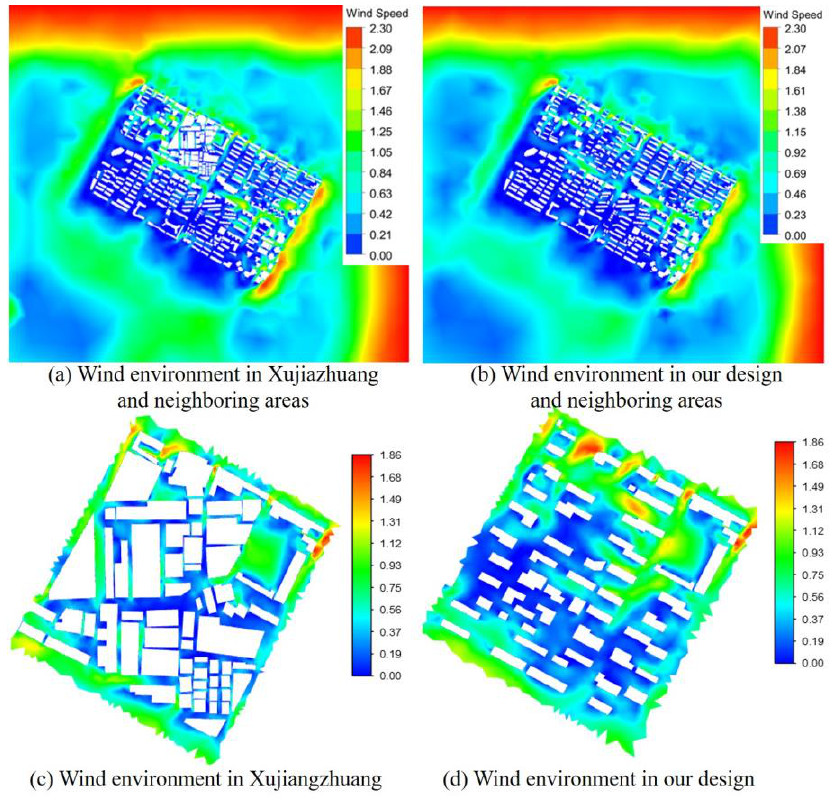
Figure 9. Wind environment simulation by CFD.